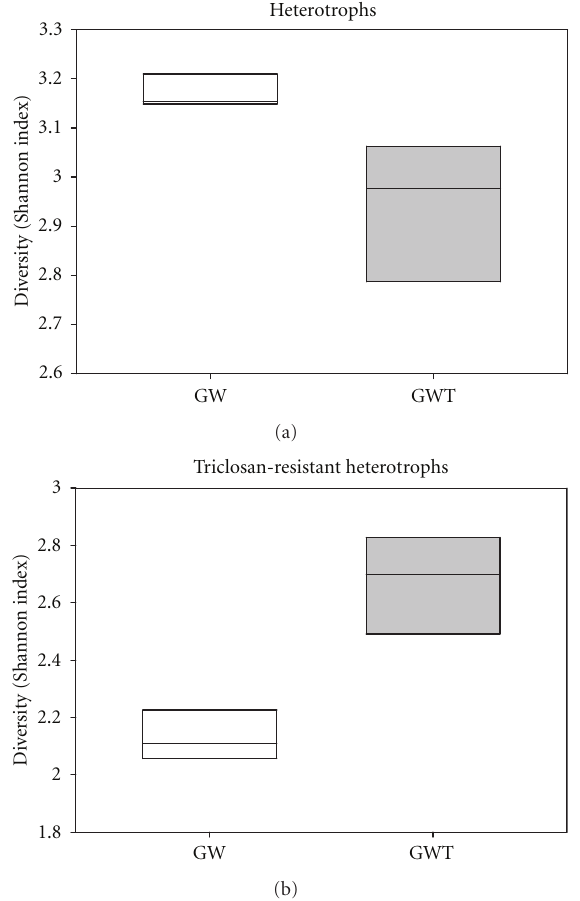
Figure 4: Diversity (Shannon index) of soil microbial communities after 10 weeks of